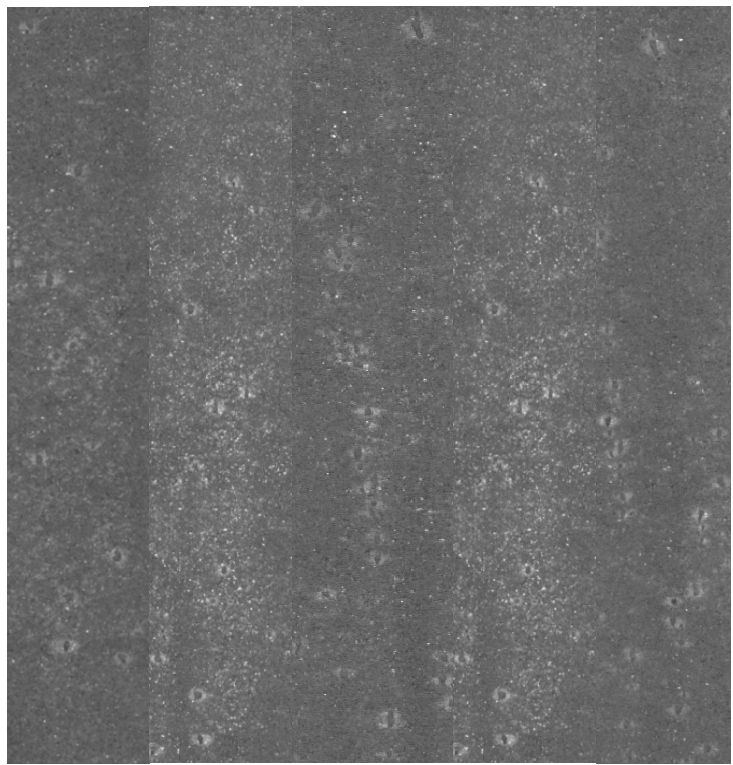
Figure 2. Roll marks on the same batch.